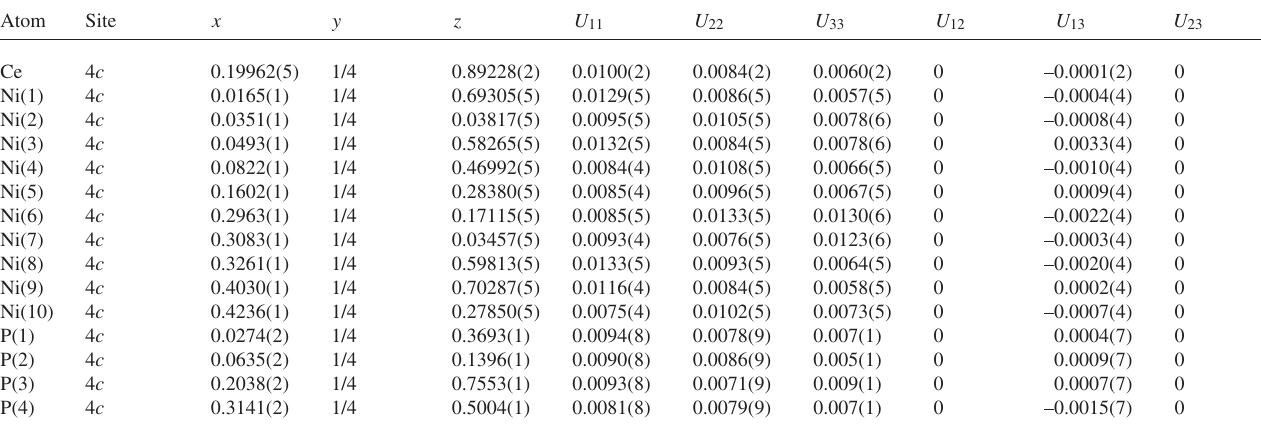
Table 2. Atomic coordinates and displacement parameters (in Å 2 )